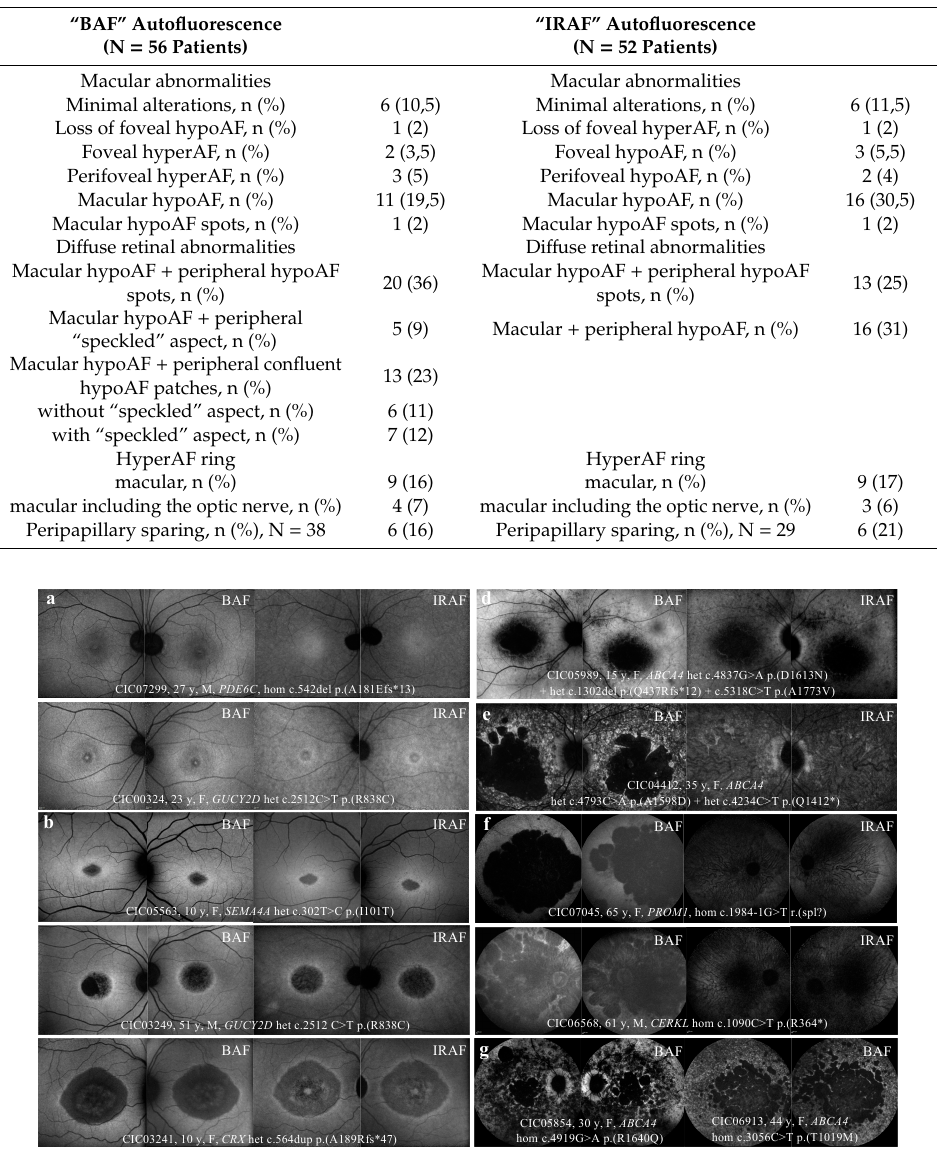
Table 4. BAF / IRAF abnormalities.